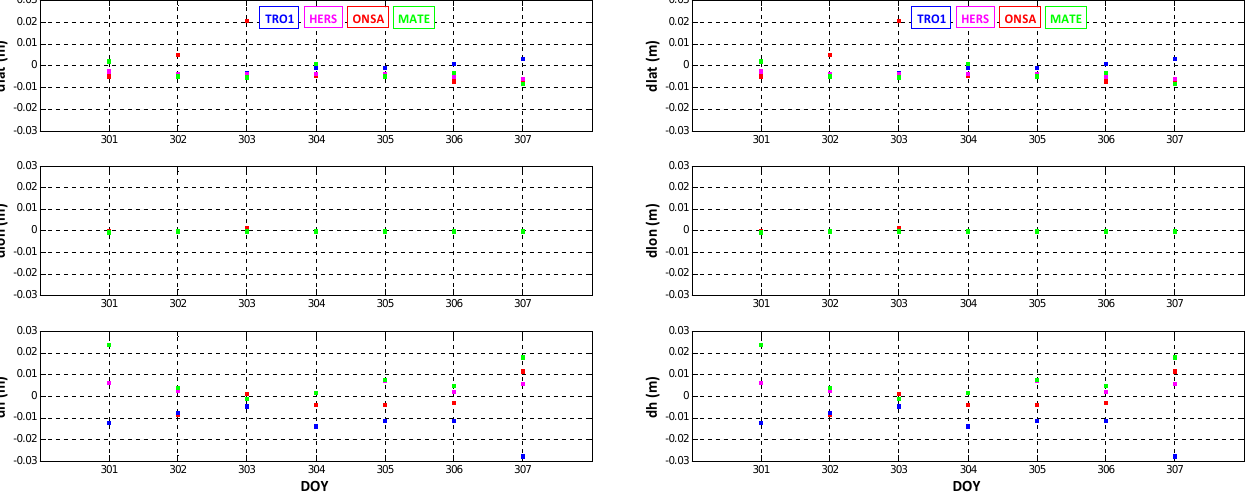
Fig. 16. “Corrected – Uncorrected” PPP results for the geodetic coordinates for the stations on DOY 301‐307 in 2003. Fig. 17. “Corrected – Uncorrected” PPP results for the geodetic coordinates for the stations on DOY 321–326 in